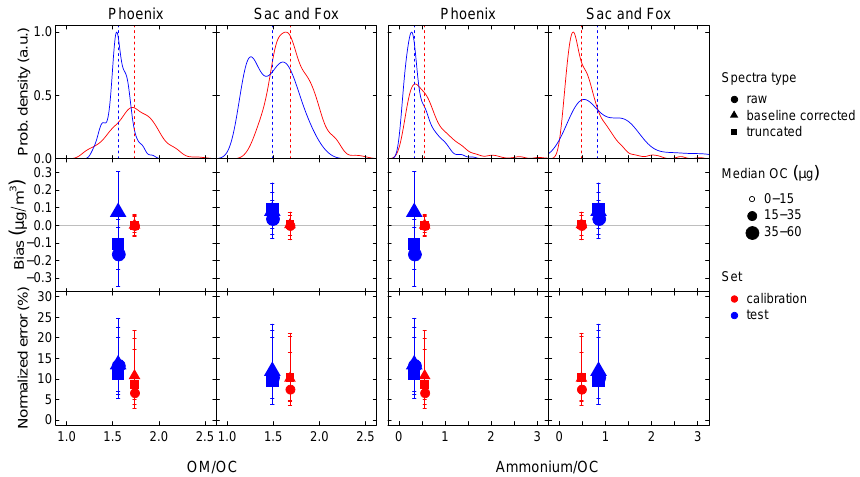
Figure 9. The OM / OC and ammonium / OC distributions and the bias and normalized error (with the interquartile range shown by error bars) in the calibration (red) and test (blue) sets for calibrations developed for Phoenix and Sac and Fox. Each calibration has all samples in the calibration set except for the site to be predicted. Vertical lines are the median of the OM / OC or ammonium / OC distributions.